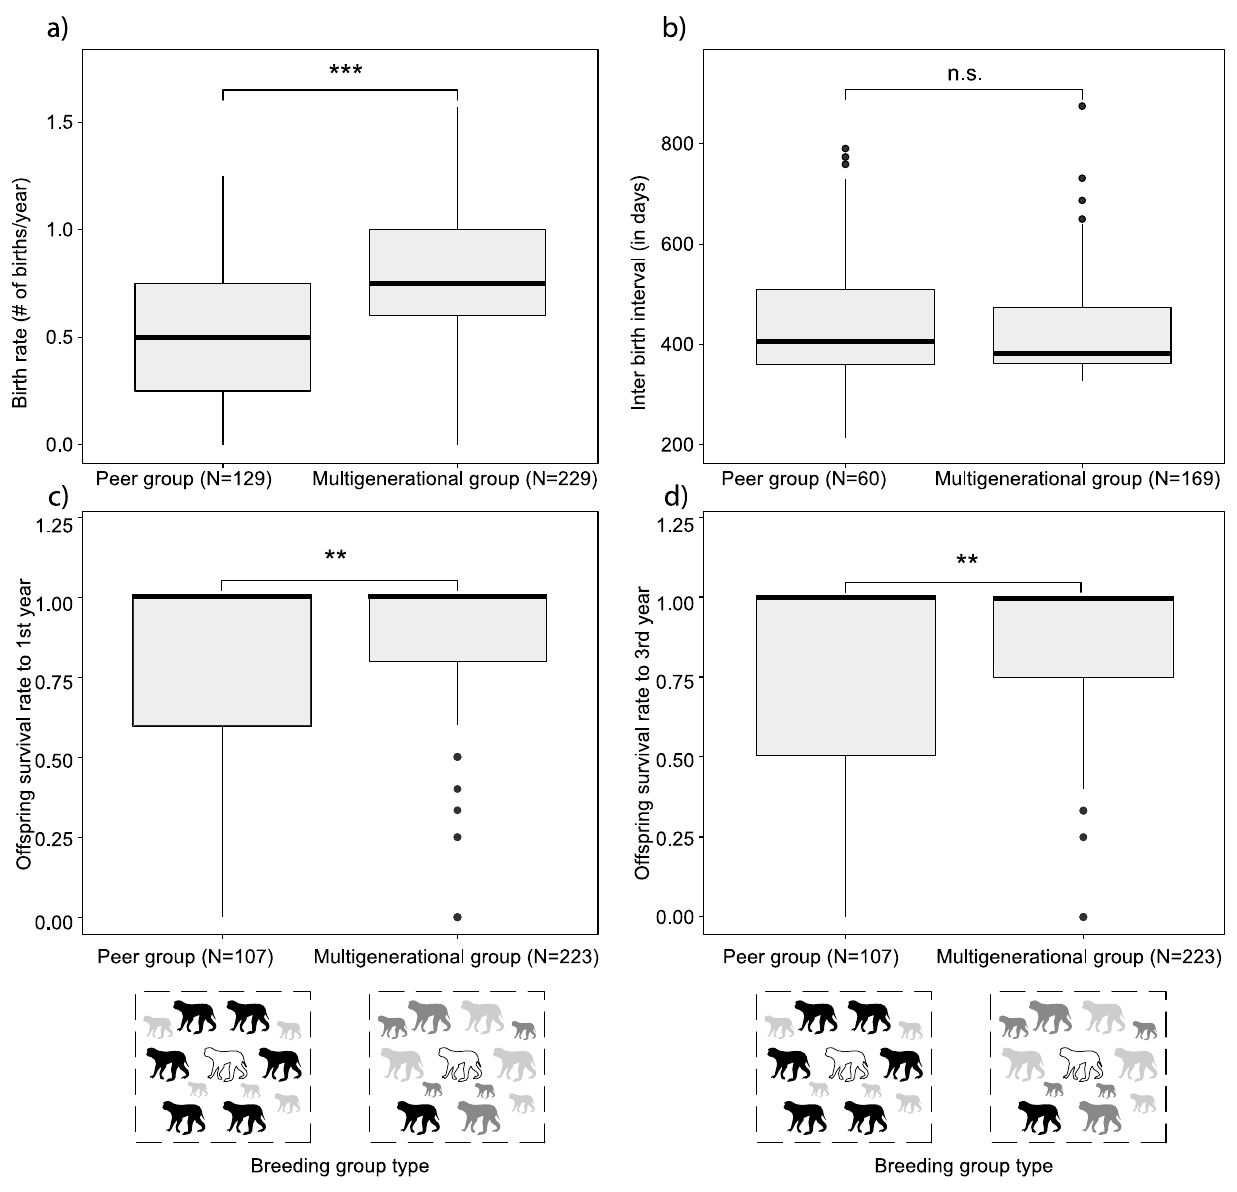
Figure 2. Birth rates, IBIs and rates of offspring survival per breeding group type: ( a ) birth rates were significantly higher in multigenerational breeding groups compared to peer breeding groups in captive rhesus macaques; ( b ) IBIs did not differ between peer and multigenerational breeding groups; ( c ) offspring survival to one year and ( d ) three years of age was significantly higher in multigenerational breeding groups compared to peer groups. ** indicates p ≤ 0.01; *** indicates p ≤ 0.001.